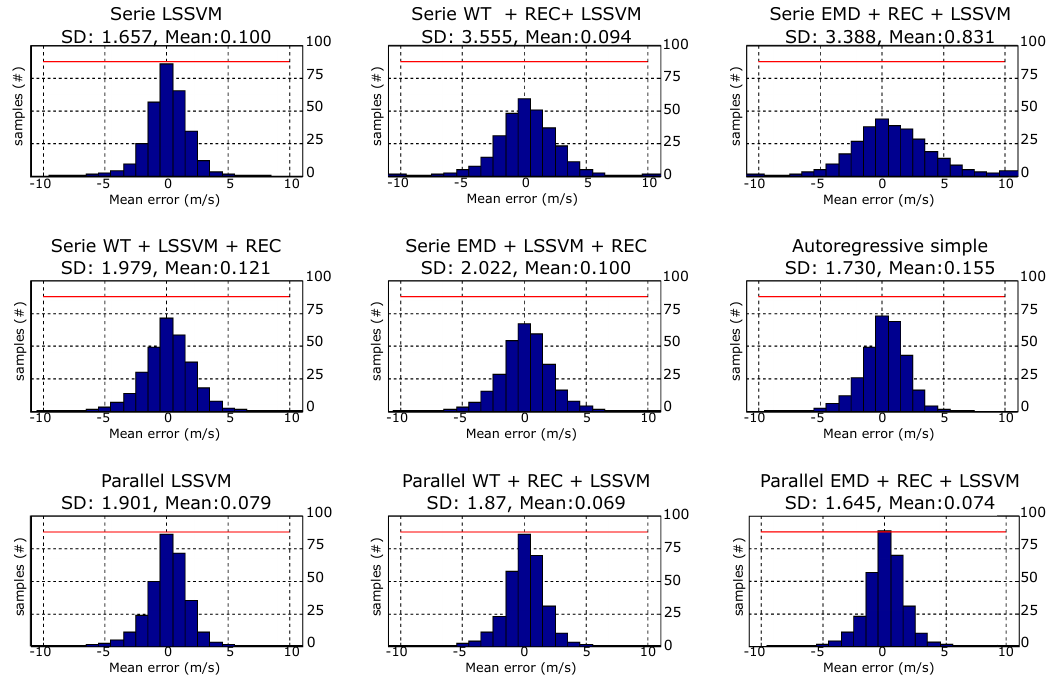
Figure 5. Histograms of the predictions error for the nine prediction